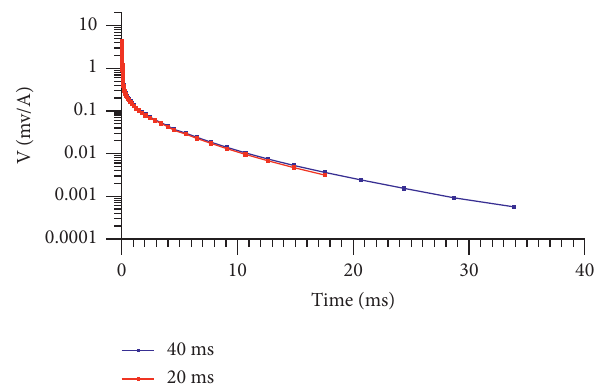
Figure 4: Comparison of V ( t )/ I attenuation curves with time-base of 20 ms and 40ms.